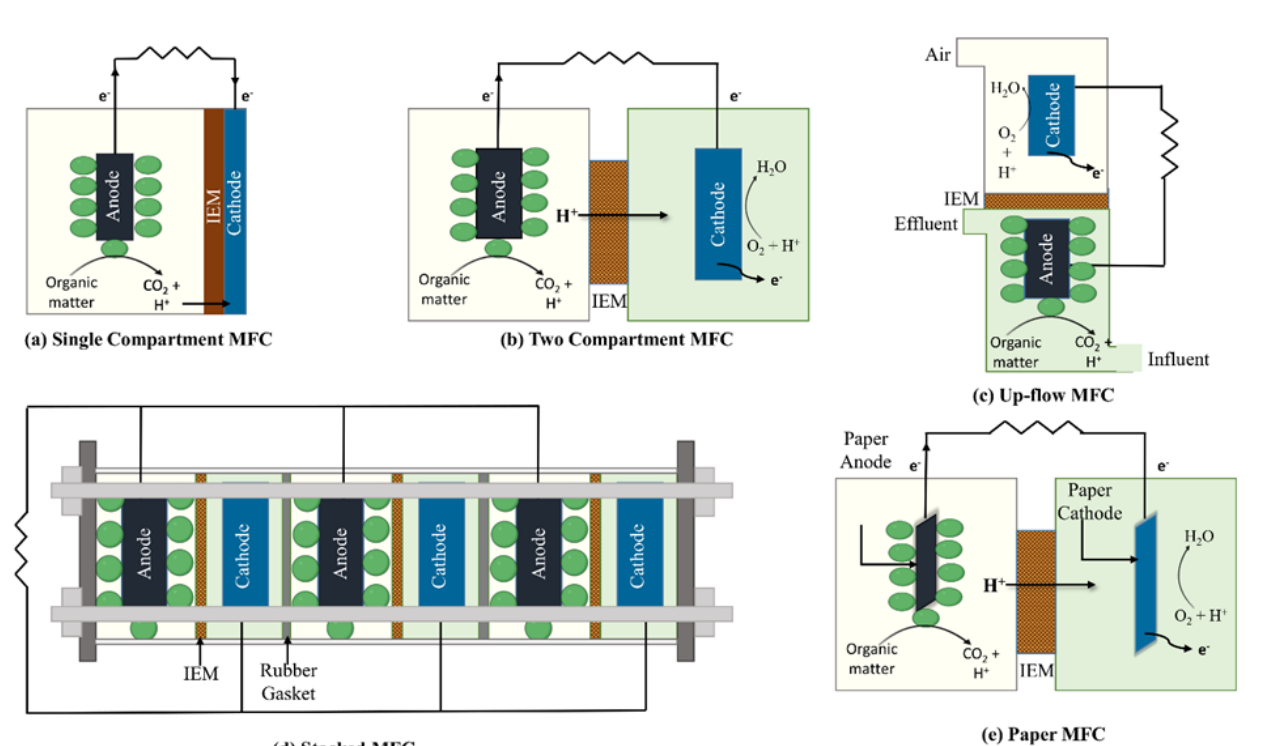
Figure 1. Different types of MFCs (IEM: ion exchange membrane).